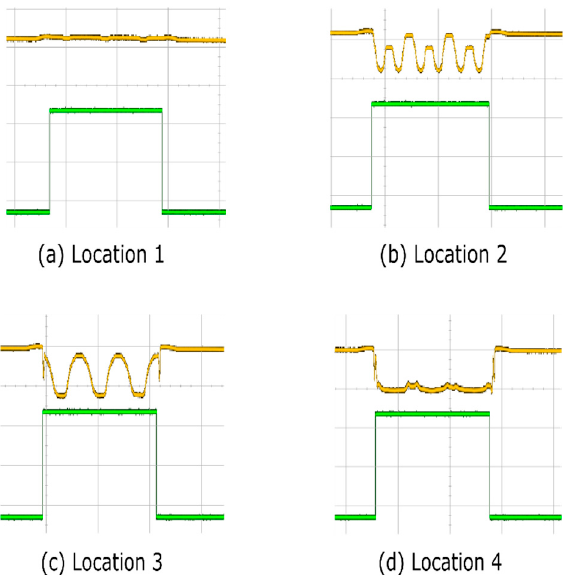
Figure 5. Waveform at each location in the photodiode.